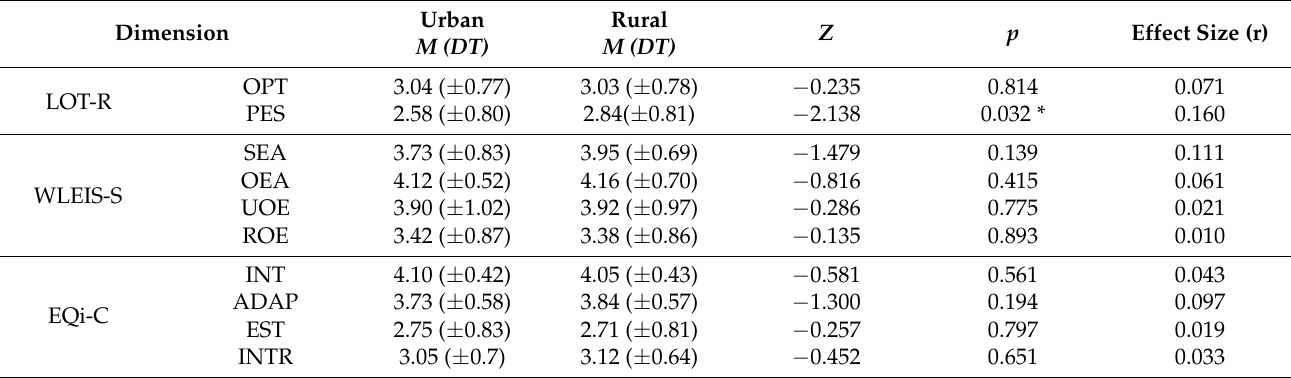
Table 3. Differences according to the context ( U of